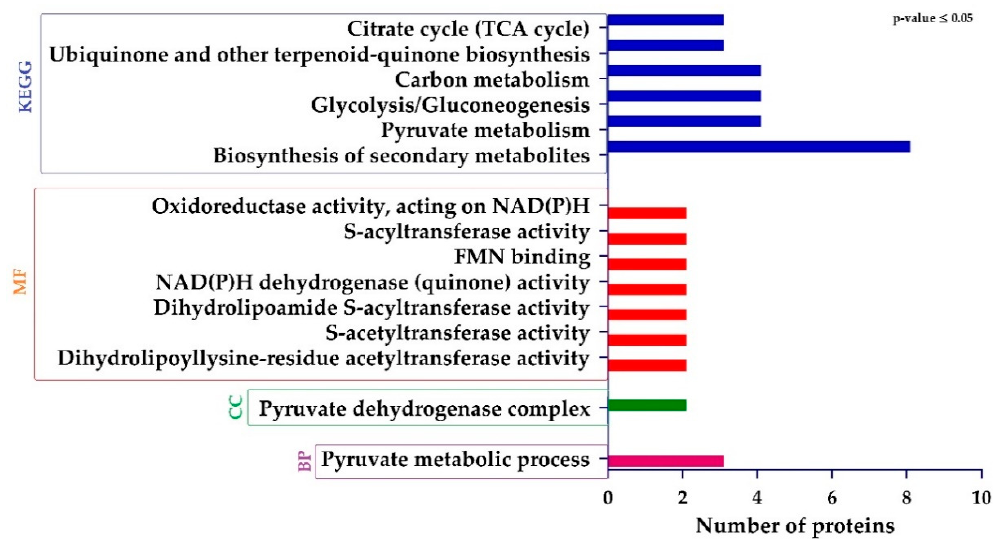
Figure 5. Histogram showing significantly enriched gene ontology (GO) annotations and Encyclopedia of Genes and Genomes (KEGG) pathways of differentially expressed proteins (DEPs).